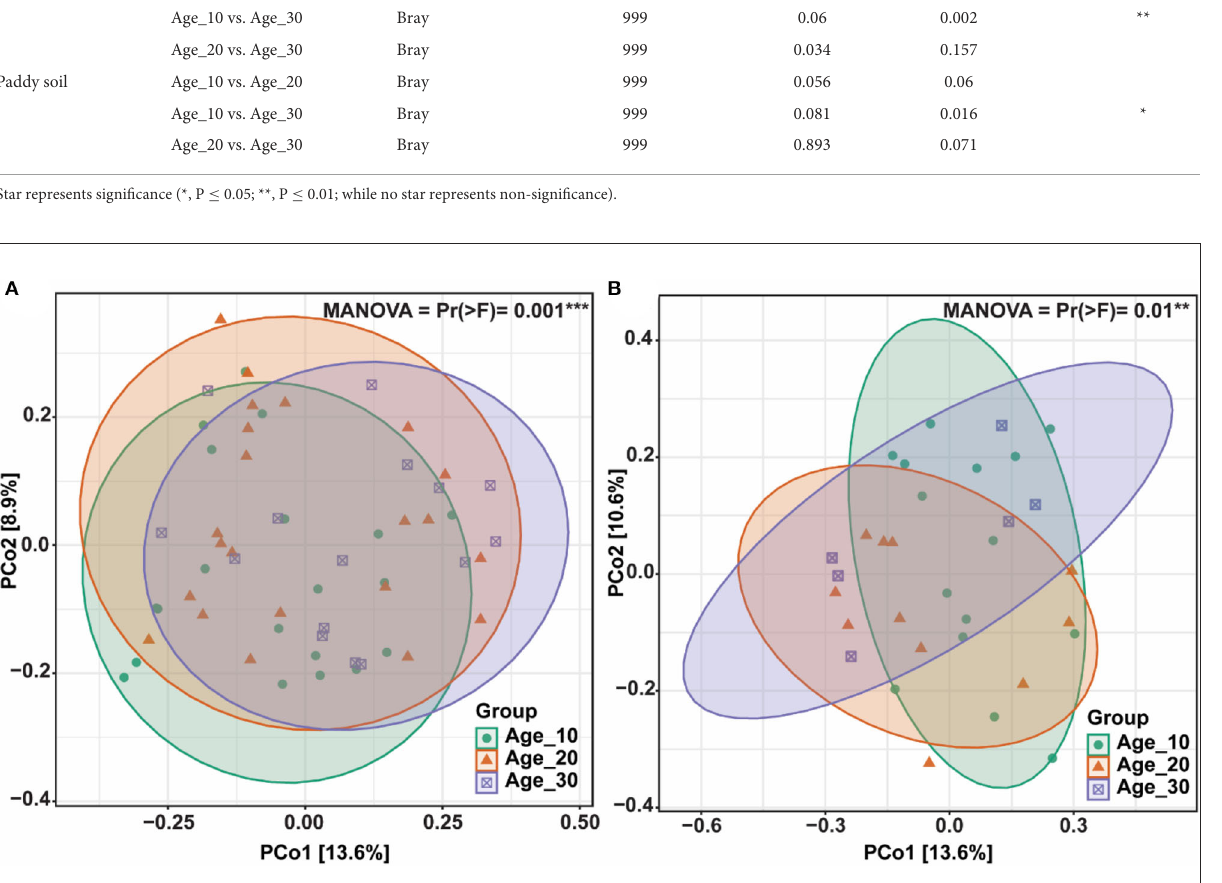
FIGURE4 Bacterial community structures and composition. Differences in bacterial community composition under different tree ages were assessed by principal coordinate analysis (PCoA); (A) red soil; and (B) paddy soil. Here, Age_10, Age_20, and Age_30 denote the different pomelo tree ages of 10, 20, and 30 years,